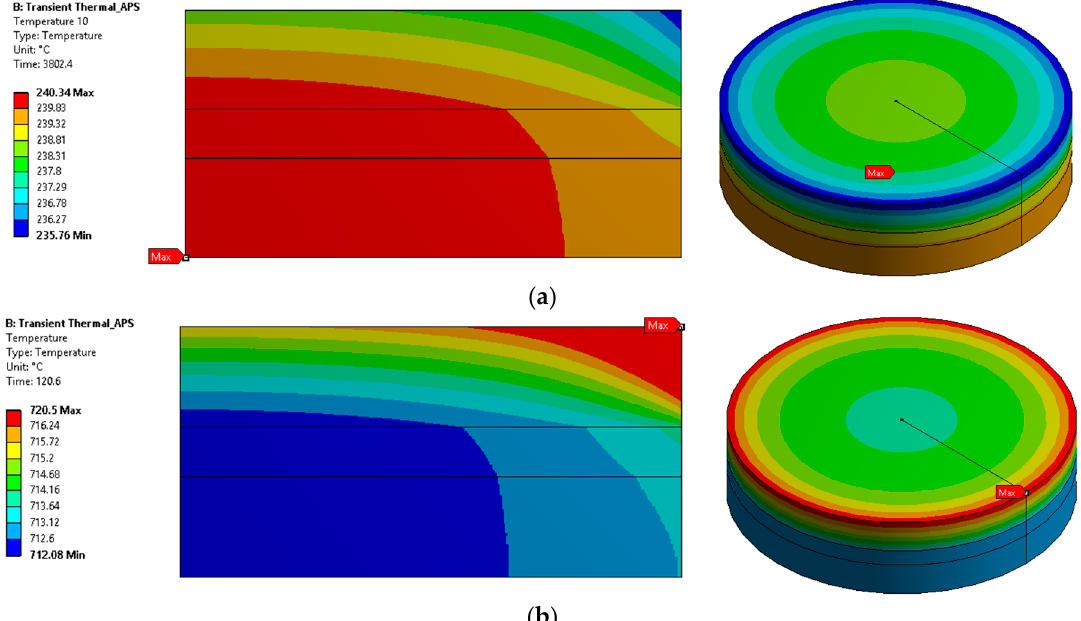
Figure 11. Temperature distribution in the coatings ( a ) during the heating cycle, and ( b ) during the cooling cycle.